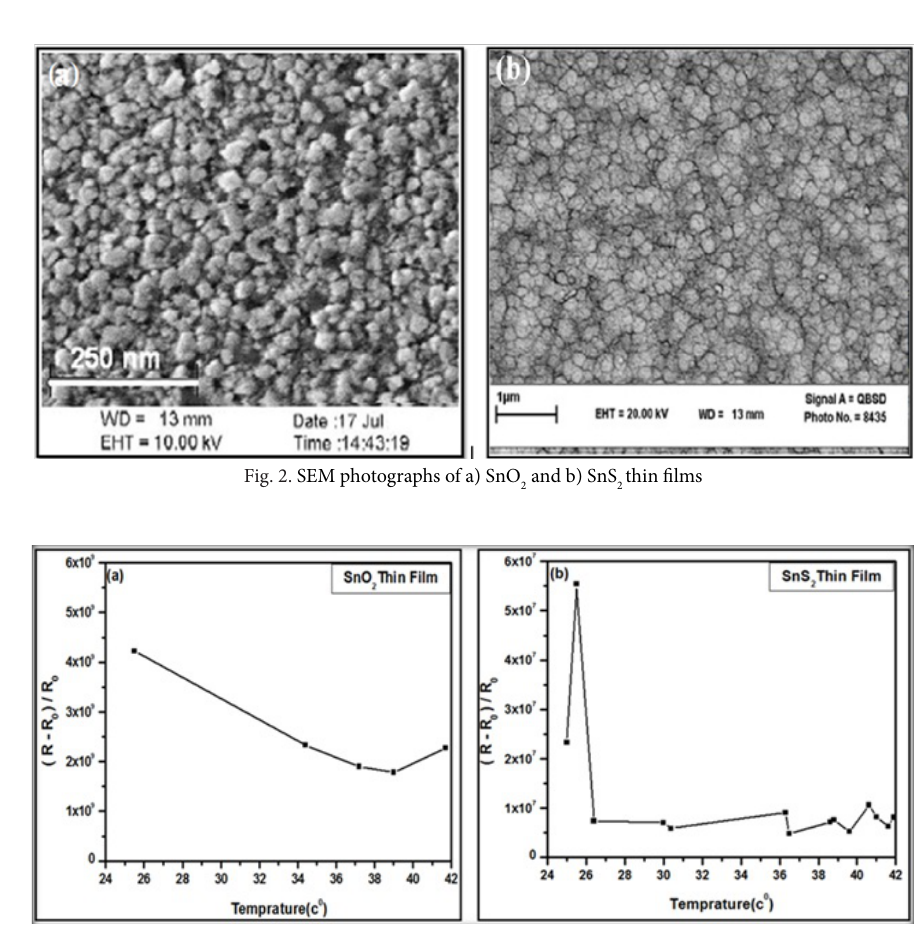
Fig. 3. plot variation resistance according to time for a) SnO Fig 3: plot variation resistance according to time for a) SnO 2 thin film and b) SnS 2 thin film